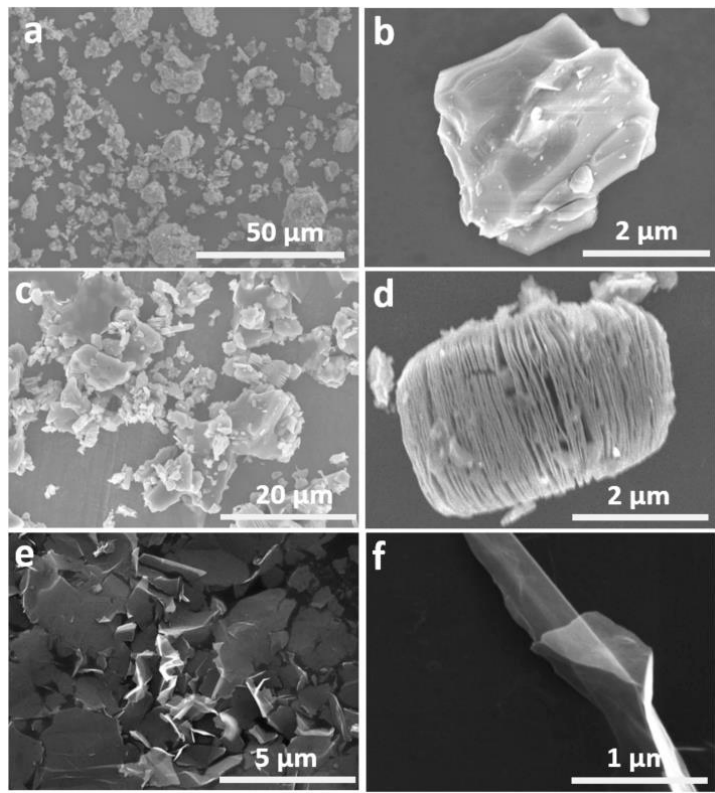
Figure 2. SEM images of Ti 3 AlC 2 MAX ( a ) at a lower magnification, ( b ) at a higher magnification; SEM images of accordion-like multi-layered Ti 3 C 2 T x ( c ) at a lower magnification, ( d ) at a higher magnification); SEM images of Ti 3 C 2 T x nanosheets ( e ) at a lower magnification, and ( f ) at a higher magnification).